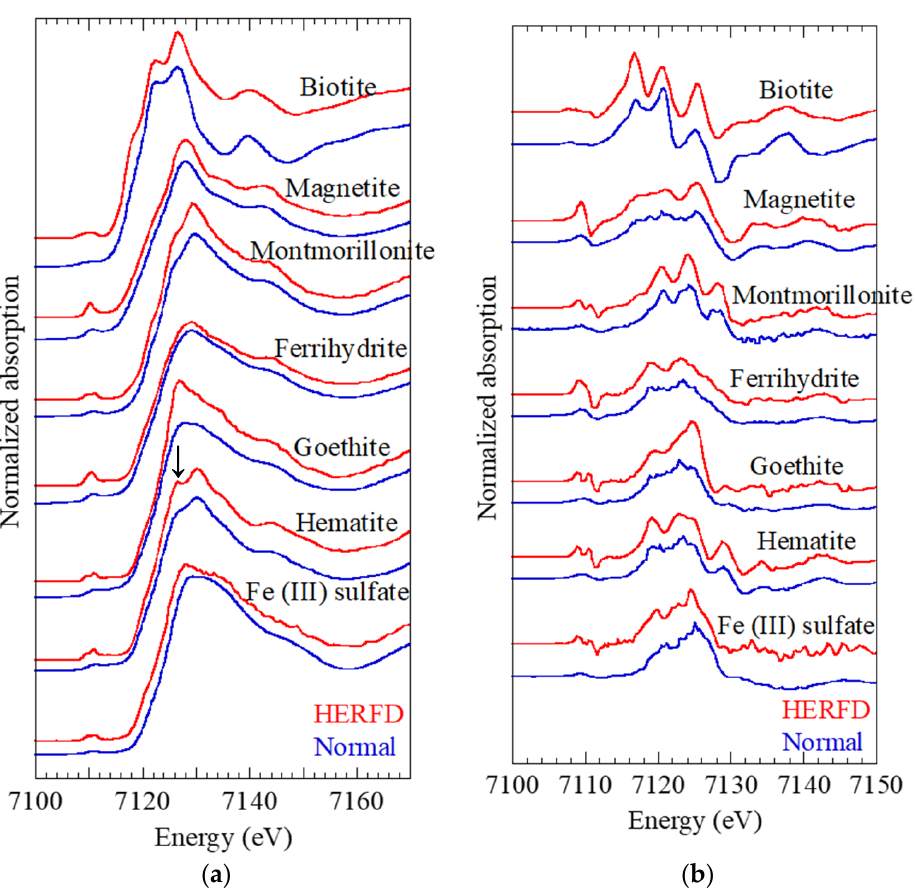
Figure 1. ( a ) XANES spectra and ( b ) First derivative XANES spectra at Fe K-edge for Fe reference materials. Red and blue lines show measured HERFD-XANES and normal XANES spectra, respectively.